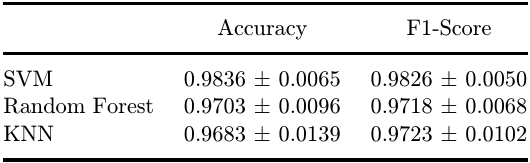
Table 2. Five-fold cross validation testing